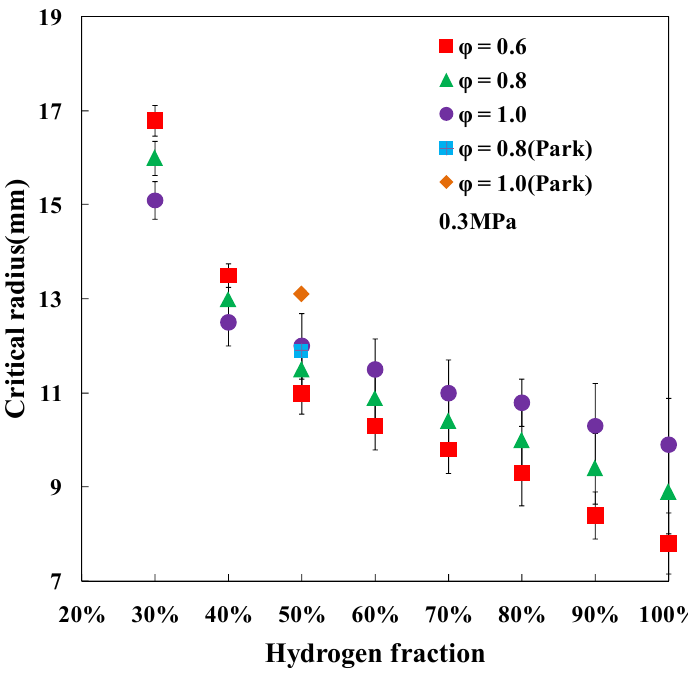
Figure 12. Critical flame radius plotted against hydrogen